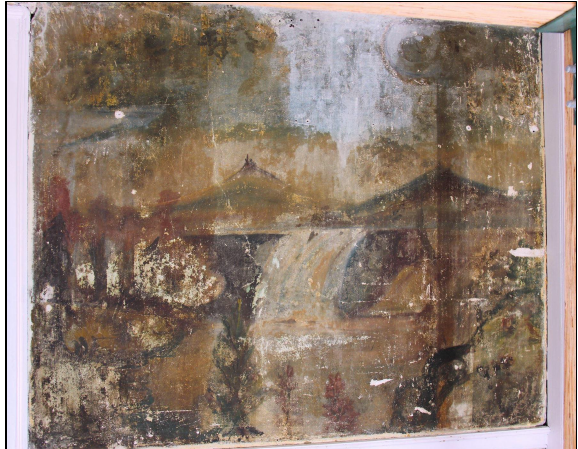
Figure 9: South wall layers of paintings. Source: Ann Shaftel